Question: From the figure, is the trend upward or downward?
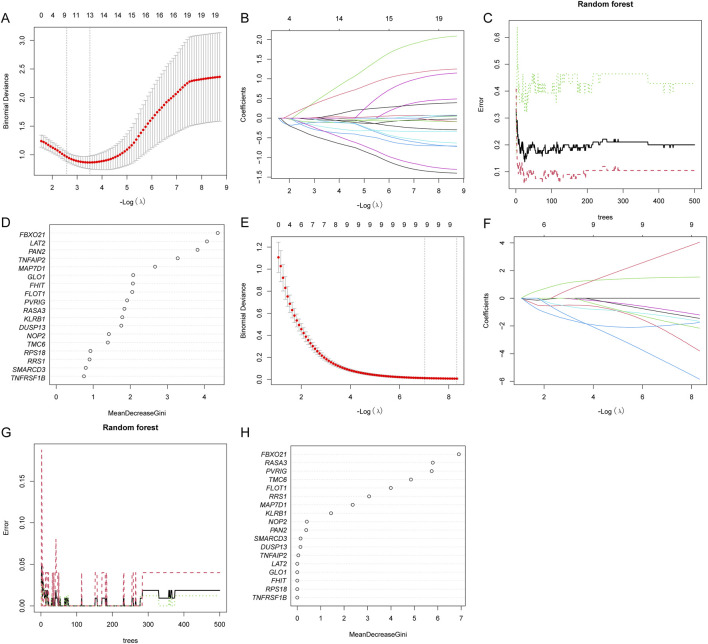
Answer: decreasing